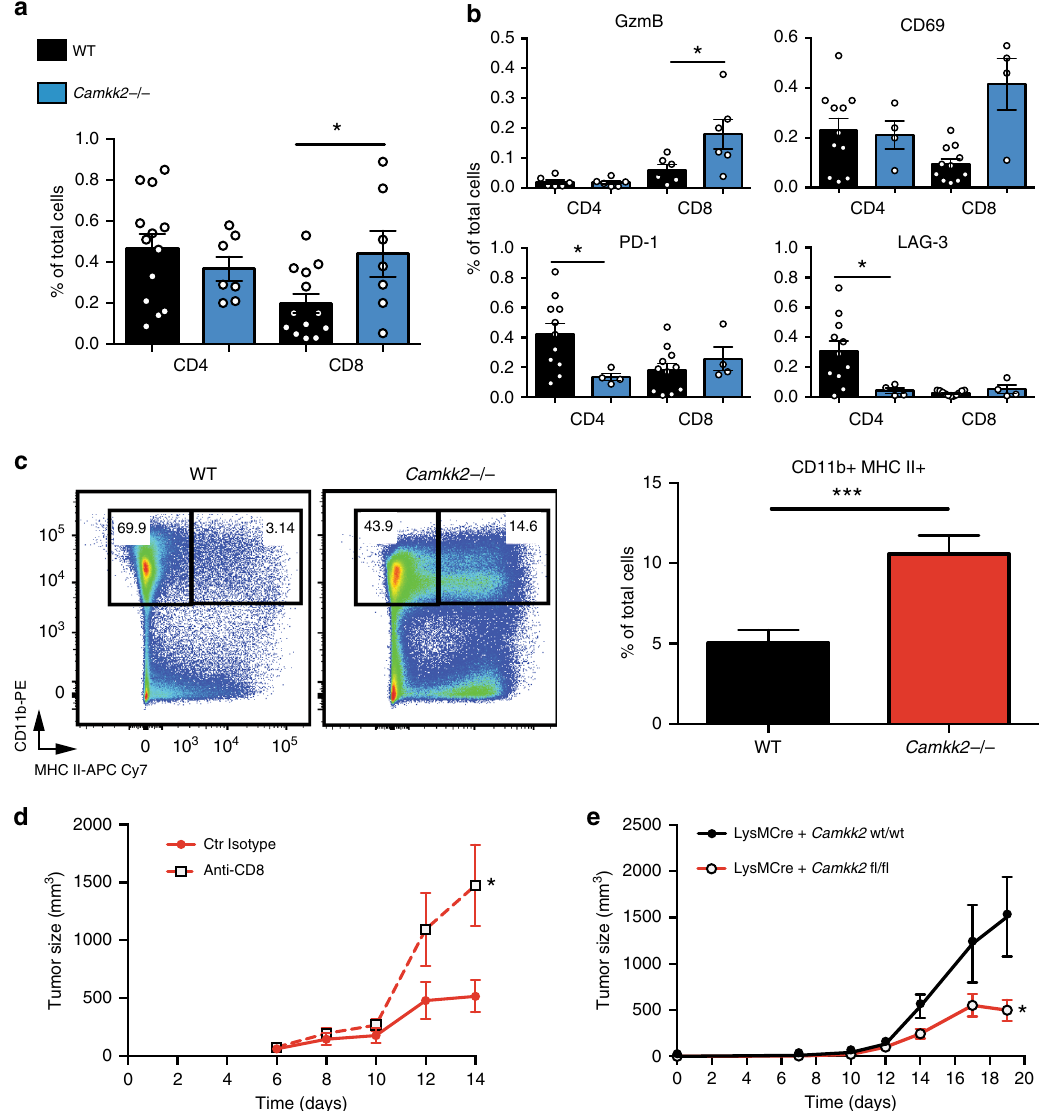
Fig. 3 Attenuated tumor growth in Camkk2 KO host is mediated by CD8 + T cells. Murine E0771 (4 × 10 5 ) cells were orthotopically grafted in WT and Camkk2 − / − mice, and subsequently tumors of comparable sizes (500 – 700 mm 3 ) were harvested and digested with both collagenase and DNase I. Single- cell suspensions were then stained for lymphoid and myeloid markers, and cell subsets were identi fi ed according with gating strategy reported in Supplementary Fig. 3A – C. a Increased accumulation of CD8 + T cells in E0771 cell-derived tumors propagated in Camkk2 − / − mice compared with WT. Bar graph reports the mean ± SEM from two combined independent experiments. b Percentages of tumor-in fi ltrating lymphocyte subsets in E0771 tumors growing in Camkk2 − / − mice compared with WT. (upper left panel) Intracellular expression of Granzyme B + (GzmB + ). CD69 + , PD-1 + , and LAG-3 + expression was detected on an independent set of eight and four tumors removed from WT and Camkk2 − / − mice, respectively. Bar graph reports the mean ± SEM. A t test was used to calculate p -values. c Representative FACS dot plots of tumor single-cell suspensions stained with myeloid markers (left). Bar graph reports the mean ± SEM of CD11b + MHC II + subset from combined independent experiments. A t test was used to calculate p -values. N = 13 and 15 tumors removed from WT and Camkk2 − / − mice, respectively. d Mammary tumor growth in Camkk2 − / − mice depleted of CD8 + T cells. Camkk2 − / − mice were treated with anti-CD8 antibody or control isotype every 3 days starting a week before tumor cell inoculation. At day 0, E0771 cells were orthotopically grafted, and mice were treated with antibodies every 4 days. Graph depicts tumor size (mean ± SEM; N = 6 in each group). e Mammary tumors display retarded growth in mice devoid of Camkk2 in myeloid cells. E0771 cells were orthotopically grafted into LysMCre + Camkk2 wt/wt and LysMCre + Camkk2 fl / fl mice. Tumor volume was measured (mean ± SEM; N = 4 for each group). This experiment was replicated with similar results. A two- way ANOVA test was used to calculate p -values. * p < 0.05, *** p <